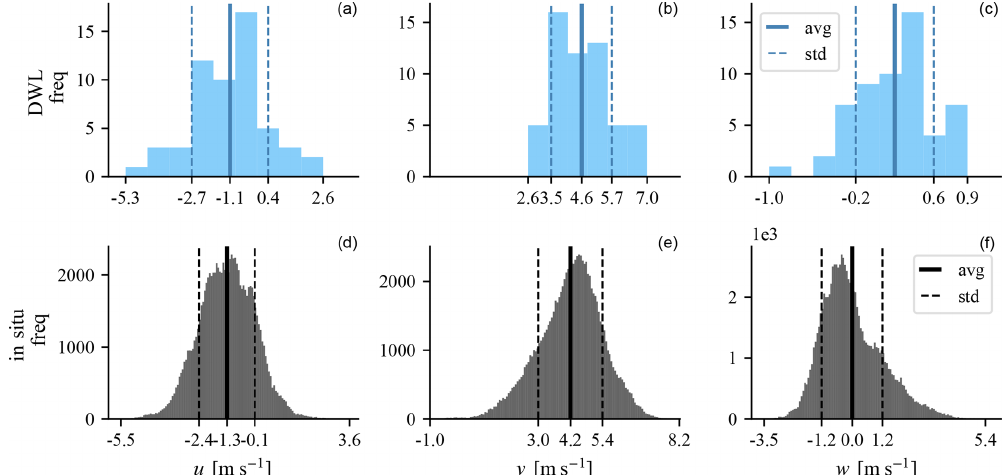
Figure 4. Distribution of u , v , and w wind in the sub-cloud layer of the western track at 617m altitude on 4 June 2019, as measured by the Doppler wind lidar (DWL; a–c , blue) and the in situ turbulence probe ( d–f , black). The DWL range bin closest to the in situ flight height was